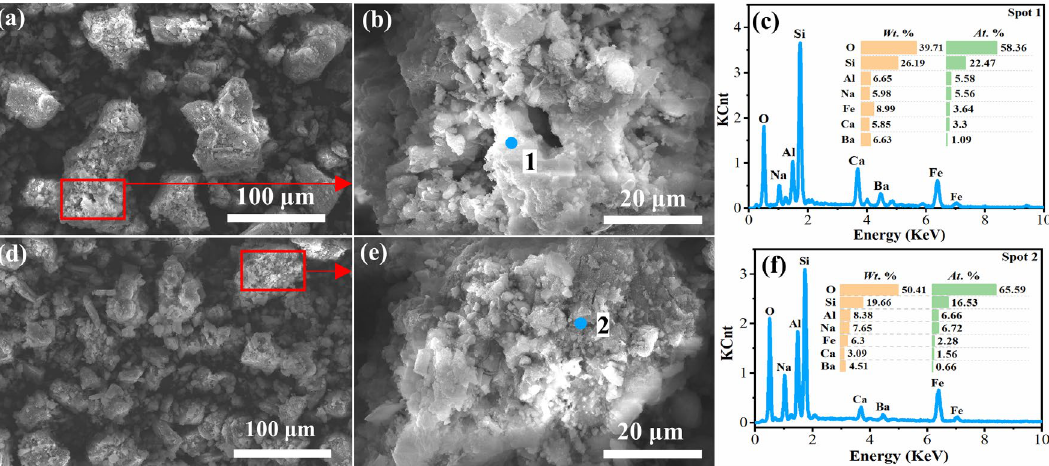
Figure 9. SEM image and EDS analysis of water leaching residue at 15 min ( a – c ) and 30 min ( d – f ).